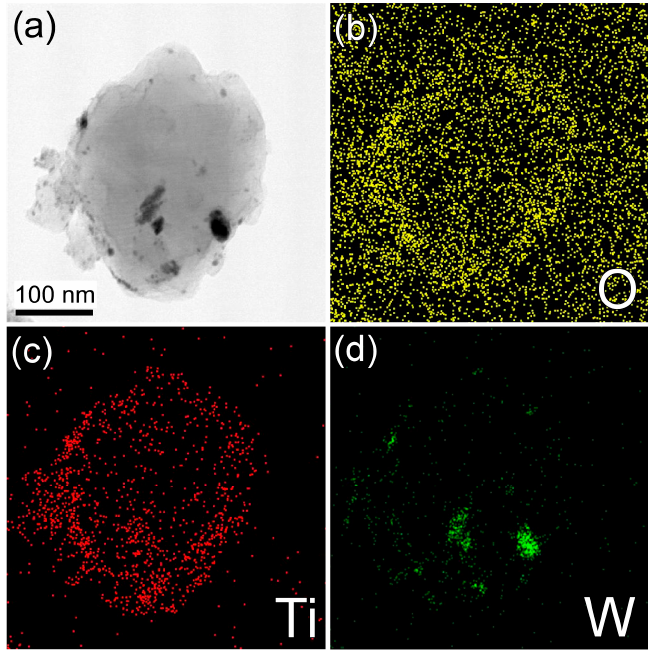
Figure 7. TEM image and energy-dispersive X-ray spectroscopy (EDX) results: ( a ) White field image of an 8 h wet-milled boron particle, and elemental mappings of ( b ) O; ( c ) Ti; and ( d ) W.